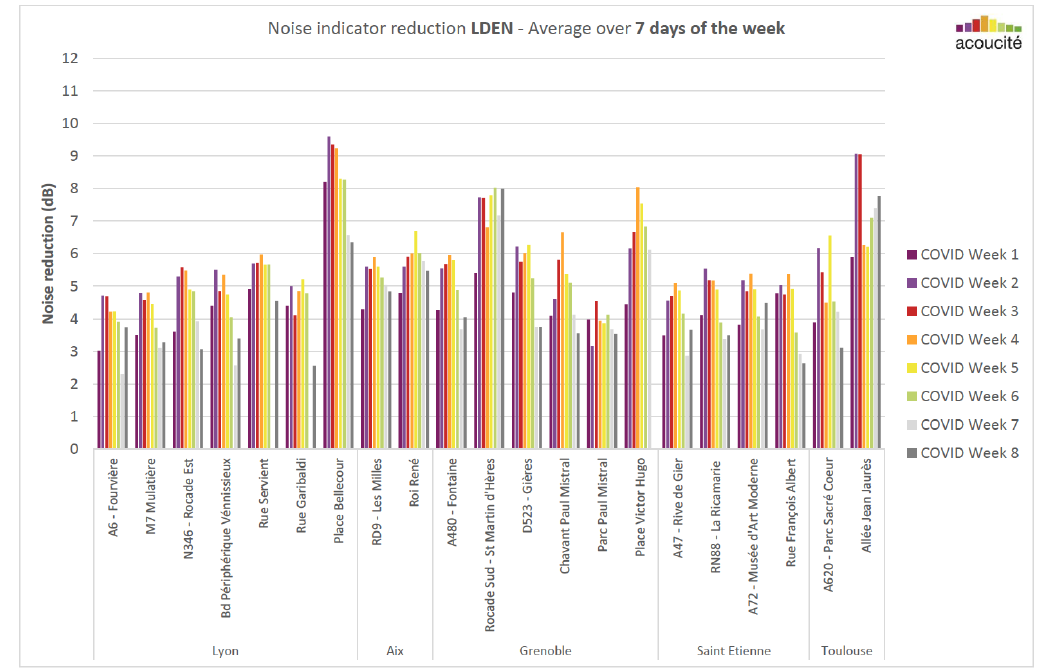
Figure 6: Evolution of the reduction in terms of sound levels per week of lockdown. Difference between the average sound level in “normal situation” and the average sound level for each week of the lockdown period